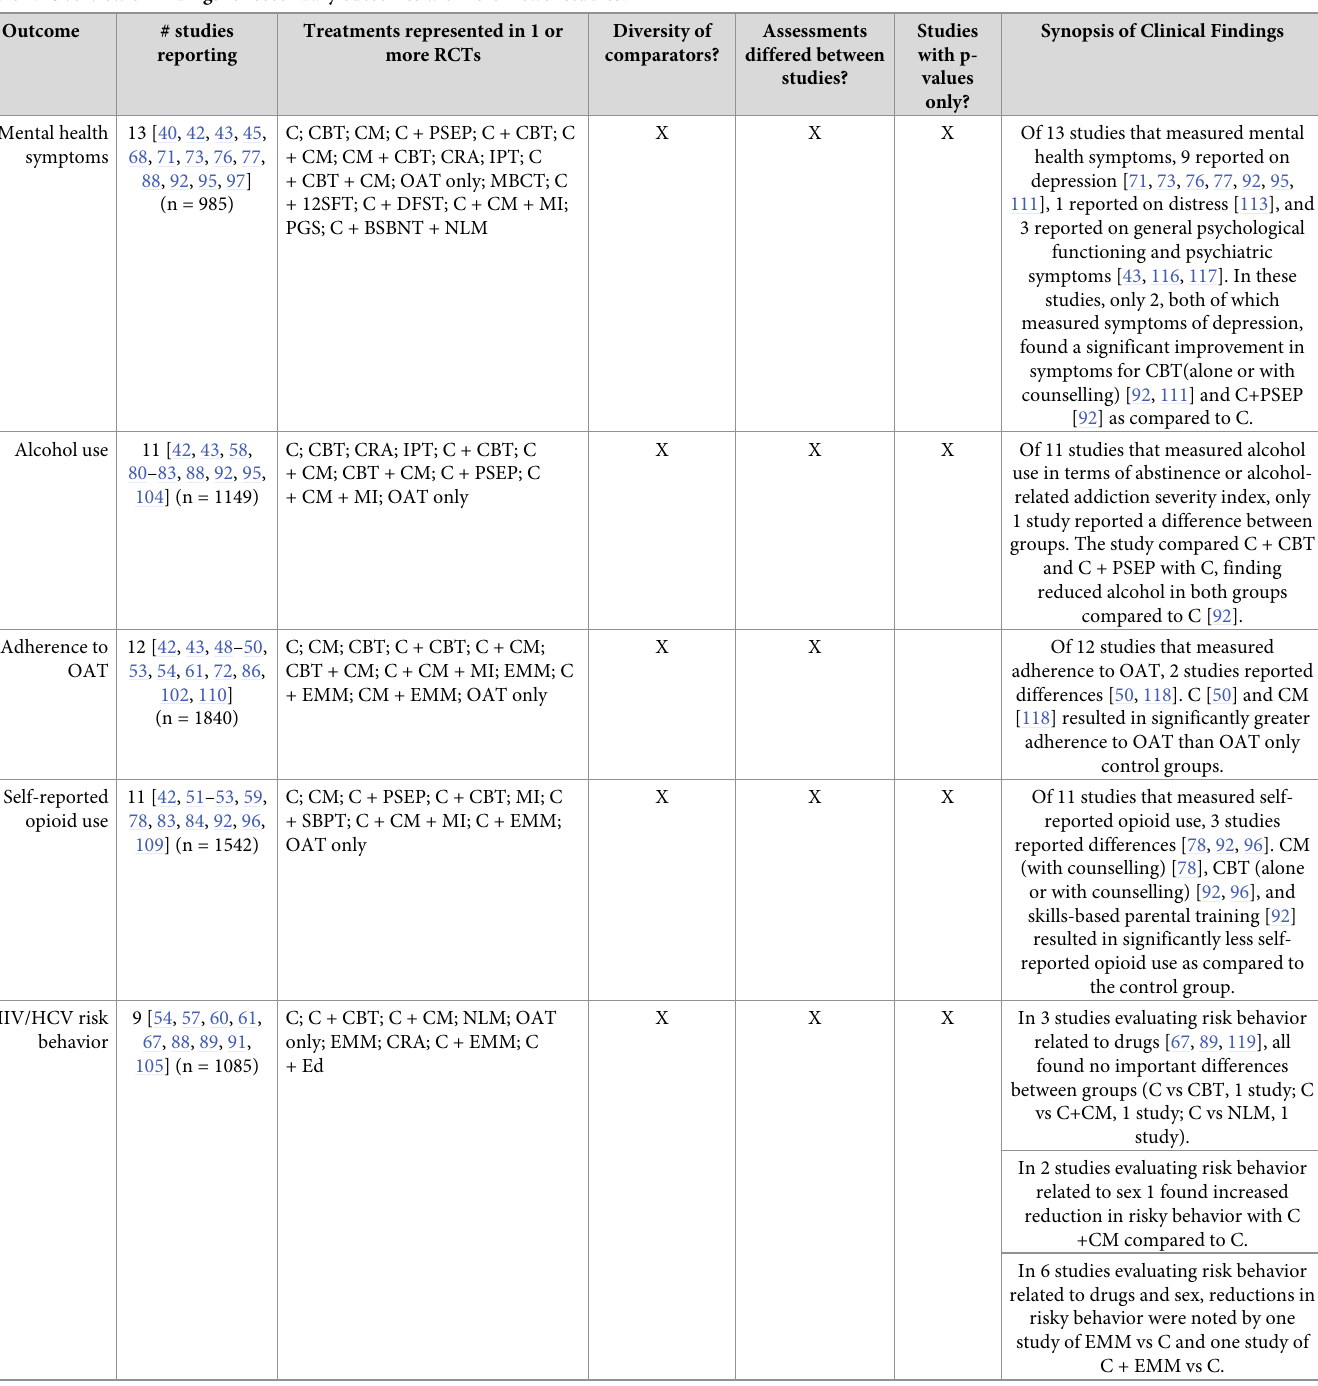
Table 2. Overview of findings for secondary outcomes with 15 or fewer